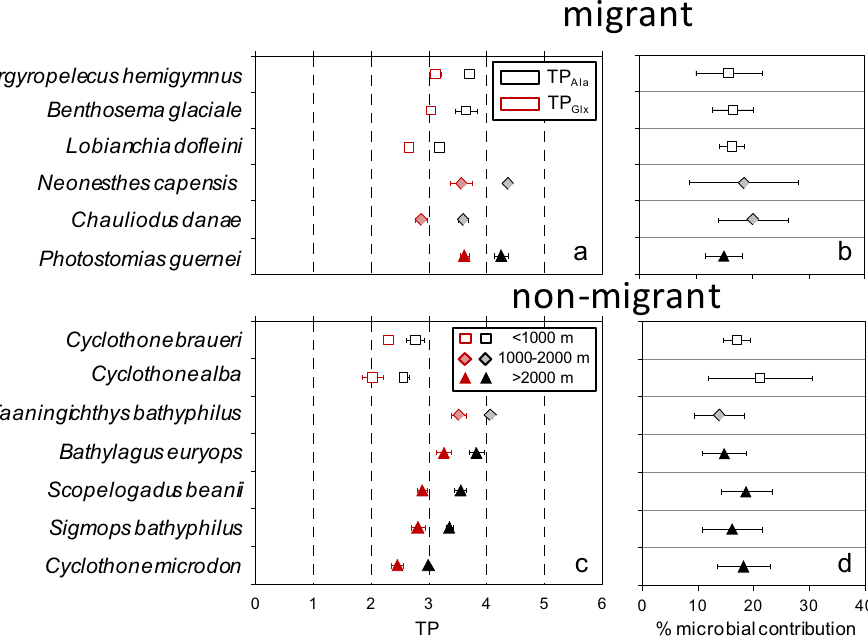
Figure 3. Mean (± s.d.) trophic positions ( a , c ) and microbial contribution ( b , d ) including microbial + metazoan (TP Ala ) or only metazoan (TP Glx ) food webs for migrant ( a , b ) or non-migrant ( c , d ) species coded by habitat depth. The values of integer TP are indicated by dashed